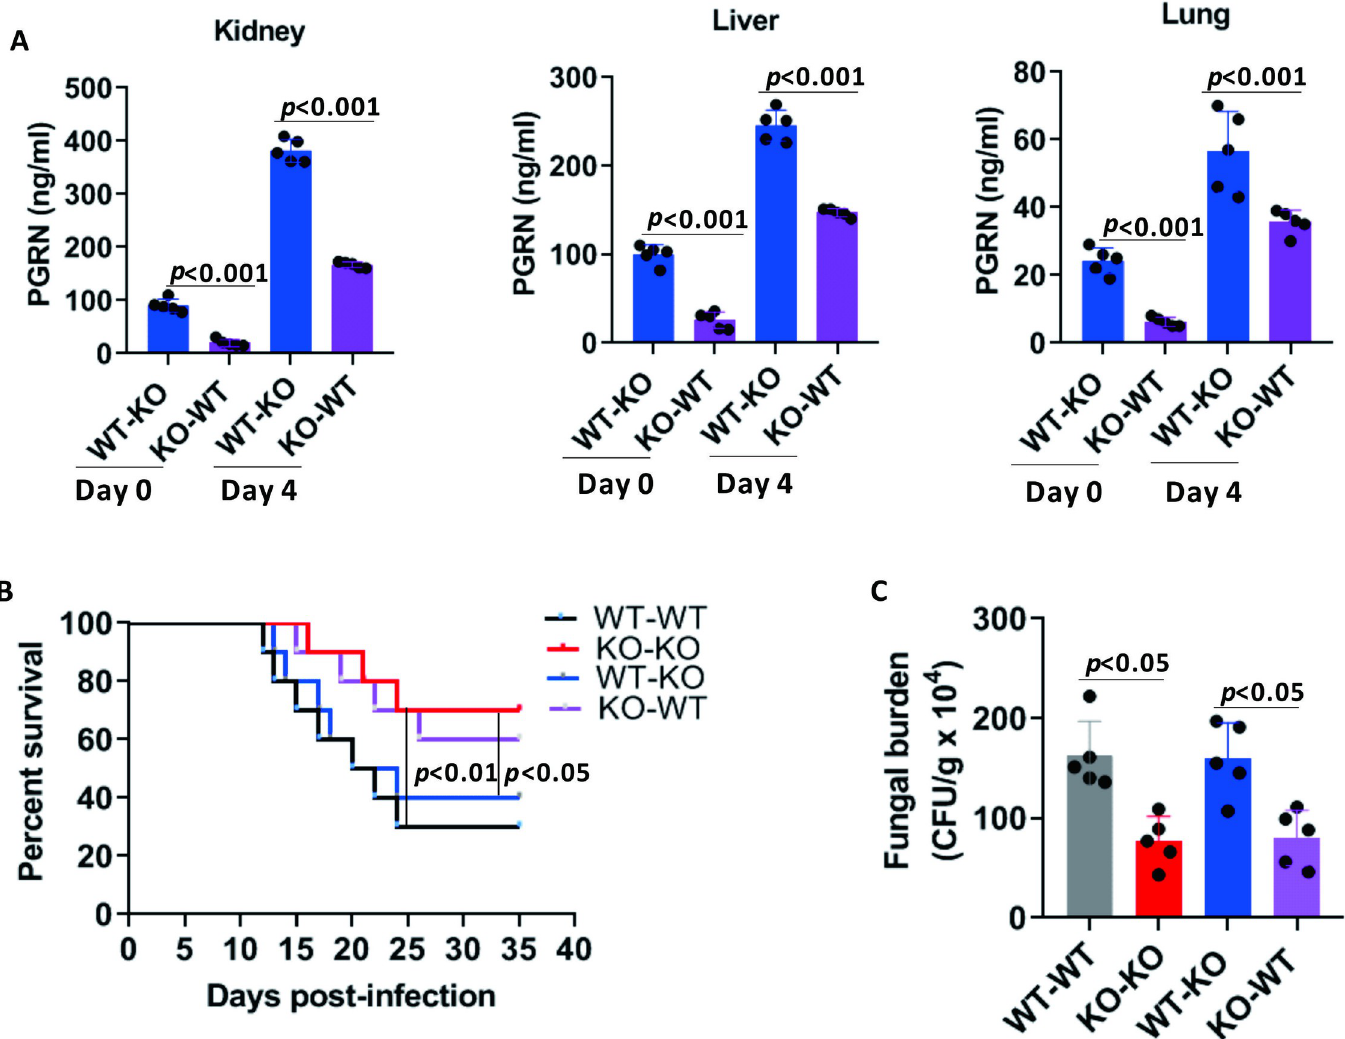
Fig 3. Contribution of PGRN-deficient hematopoietic cells to the increased resistance of PGRN KO mice to invasive C . albicans infection. (A) Bone-marrow cells from PGRN KO (n = 5) and WT (n = 5) mice were intravenously injected into the irradiated recipient mice separately. Eight weeks later, mice were intravenously infected with 4 × 10 5 CFU of C . albica n s , and PGRN levels in the kidney, liver and lung were determined by ELISA. The statistical difference was determined by Kruskal-Wallis test followed by Dunn’s multiple comparisons post test, p values were shown when compared between groups denoted by horizontal lines. (B) Bone-marrow cells from PGRN KO (n = 10) and WT (n = 10) mice were intravenously injected into the irradiated recipient mice separately. Eight weeks later, mice were intravenously infected with 4 × 10 5 CFU of C . albica n s . Survival of these mice was monitored. Kaplan-Meier survival curves were shown, and p value was determined by log-rank survival test. (C) Radiation chimeras were infected with 4 × 10 5 CFU of C . albicans by intravenous inoculation, and kidney CFU levels at day 9 after C . albicans infection were evaluated. All data were pooled from three independent experiments. The Mann–Whitney U test was used to analyze the difference between groups denoted by horizontal lines, and p values were